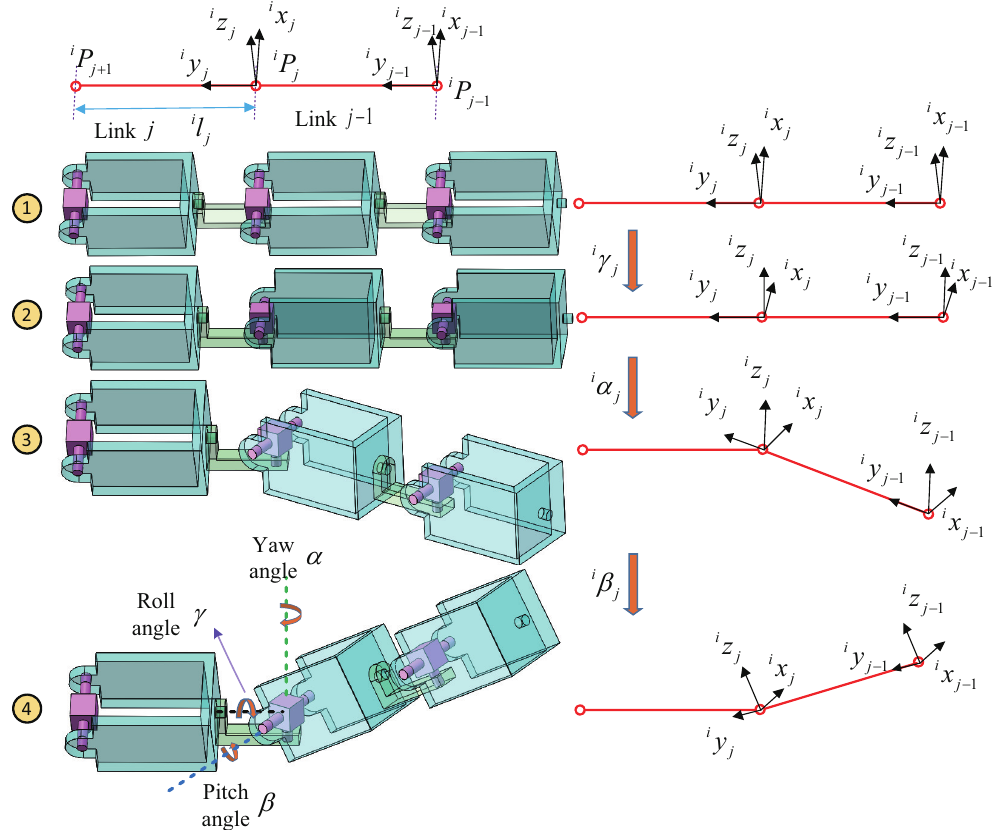
Figure 8. Local coordinates fixed on the simplified Solidworks model and descriptions of roll, pitch and yaw angles. Label 1 corresponds to the initial configuration. Label 2, 3 and 4 describe the configurations after rotating roll angle, yaw angle and pitch angle,